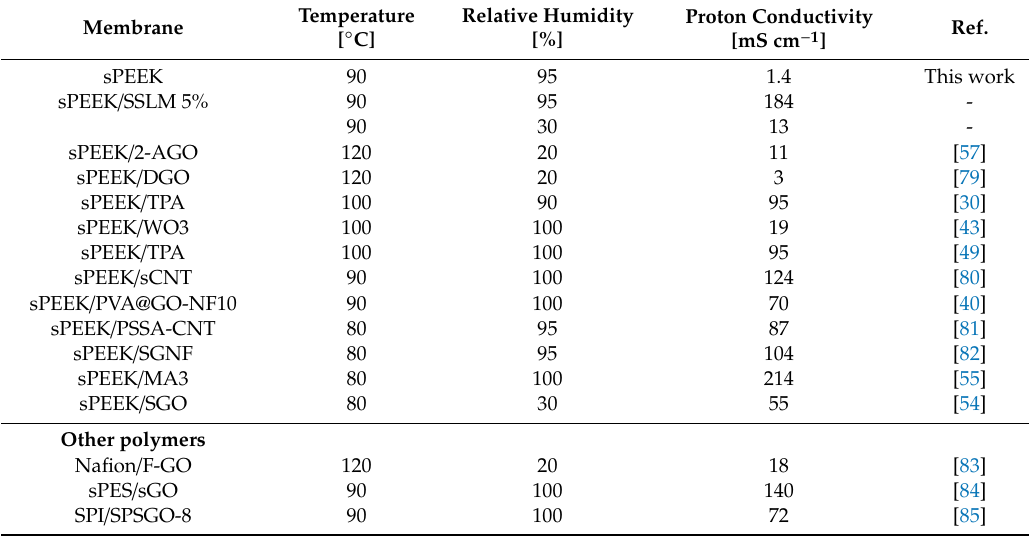
Table 2. Comparison of the proton conductivity of SPEEK / SSLM 5% membrane with state-of- the-art membranes.